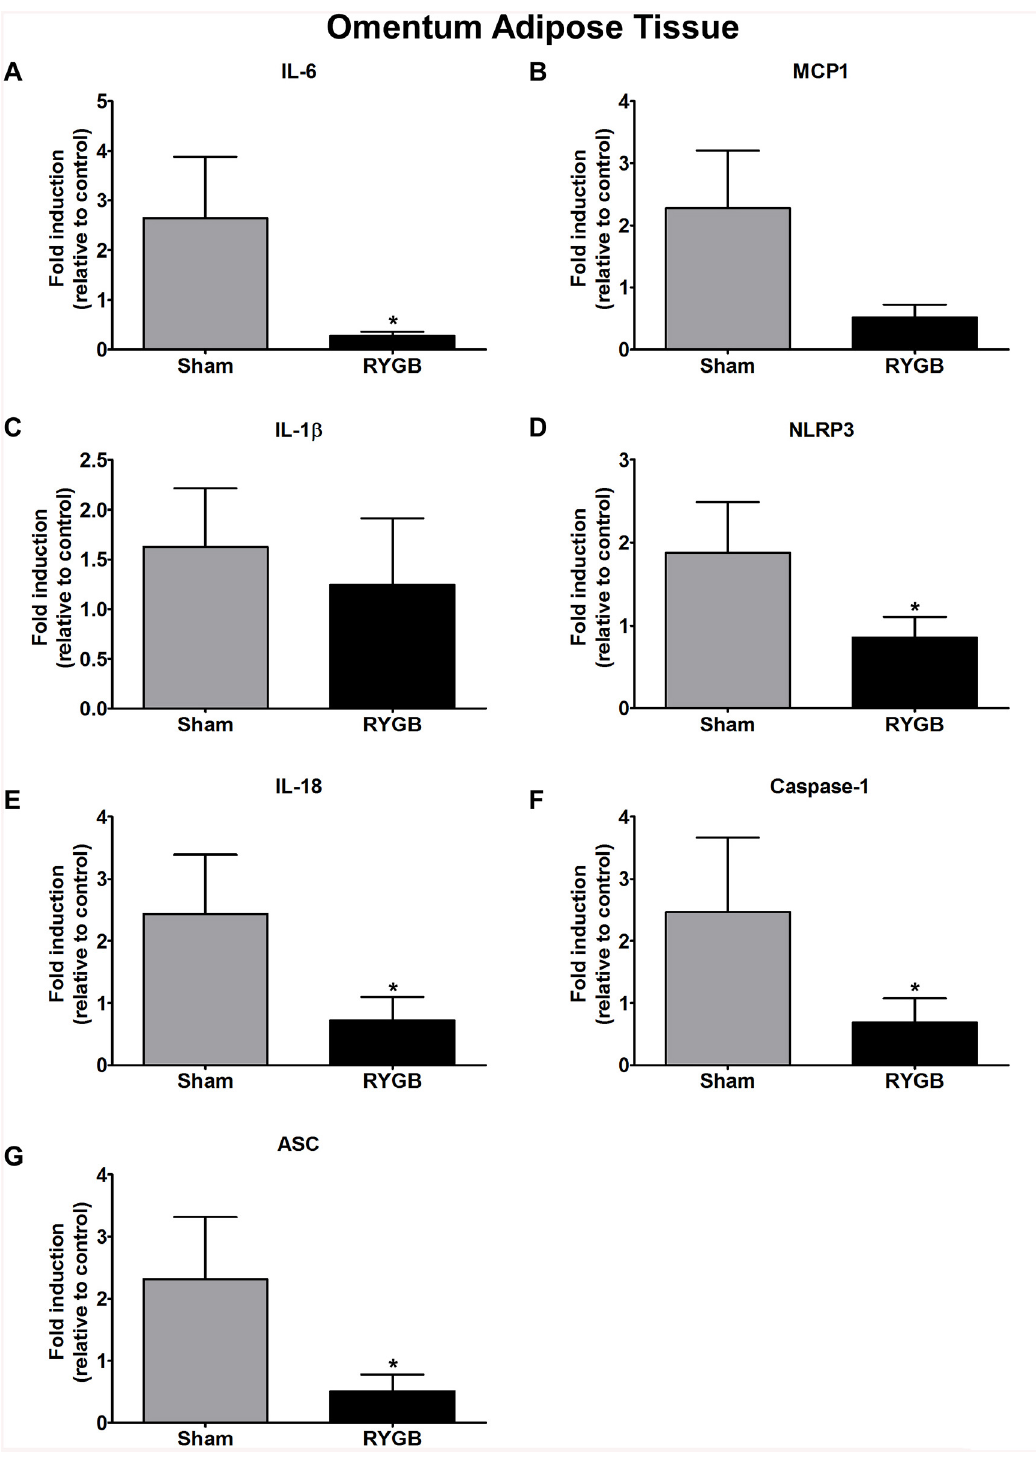
Fig 2. Expression of components of the NLRP3 inflammasome, IL – 6 (A), MCP – 1 (B), IL – 1 β (C), NLRP3 (D), IL – 18 (E), Caspase – 1 (F) and ASC (G) in Sham control (grey bar) and RYGB (black bar) omental adipose tissue. N = 8 — SHAM and N = 8 — (RYGB), data are mean ± SE, asterisk sign denoted significant different between control vs.